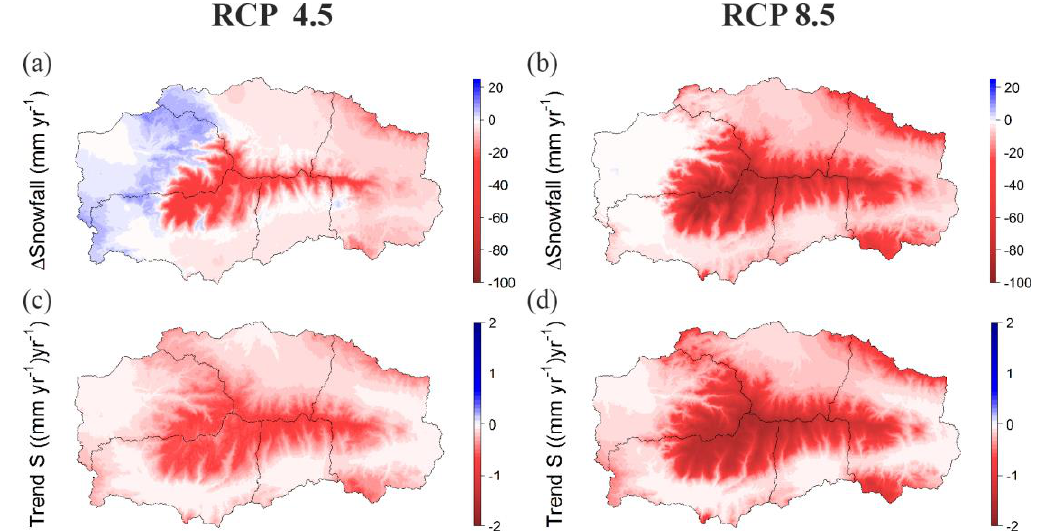
Figure 6. Spatial distribution of the ( a , b ) mean annual snowfall anomalies and ( c , d ) snowfall trends of the two global change scenarios analyzed, respectively, during the 2006–2010 period in the study area.